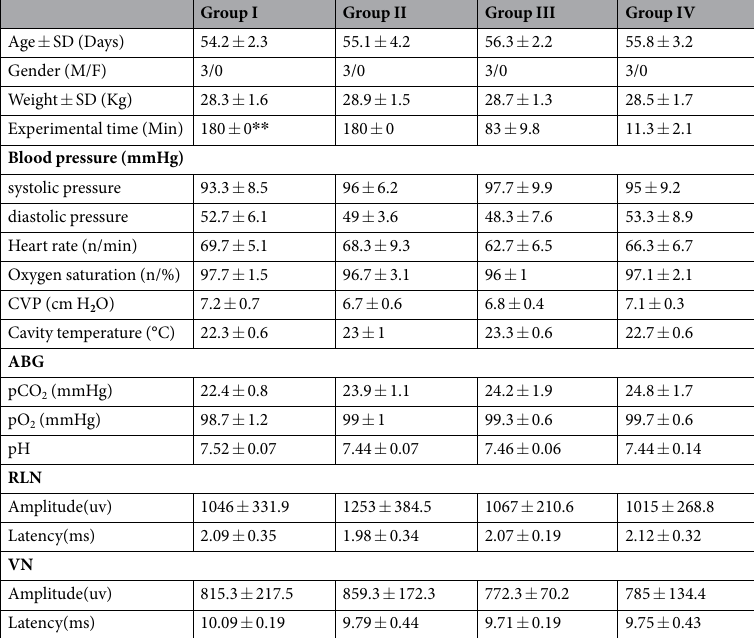
Table 1. Animal characteristics and baseline determinations. Group I: intraoperative pressure was kept at 1 times CVP; Group II: intraoperative pressure x2 CVP Group III: intraoperative pressure x3 times CVP.; Group IV: intraoperative pressure x5 times CVP. CVP: central venous pressure; ABG: arterial blood gas; RLN: recurrent laryngeal nerve; VN: vagus nerve. * P < 0.05, ** P < 0.01; analysis of the total four groups with Cochran’s and Mantel-Haenszel Chi-square ( χ CMH2 ) test, while the variable of side was controlled.